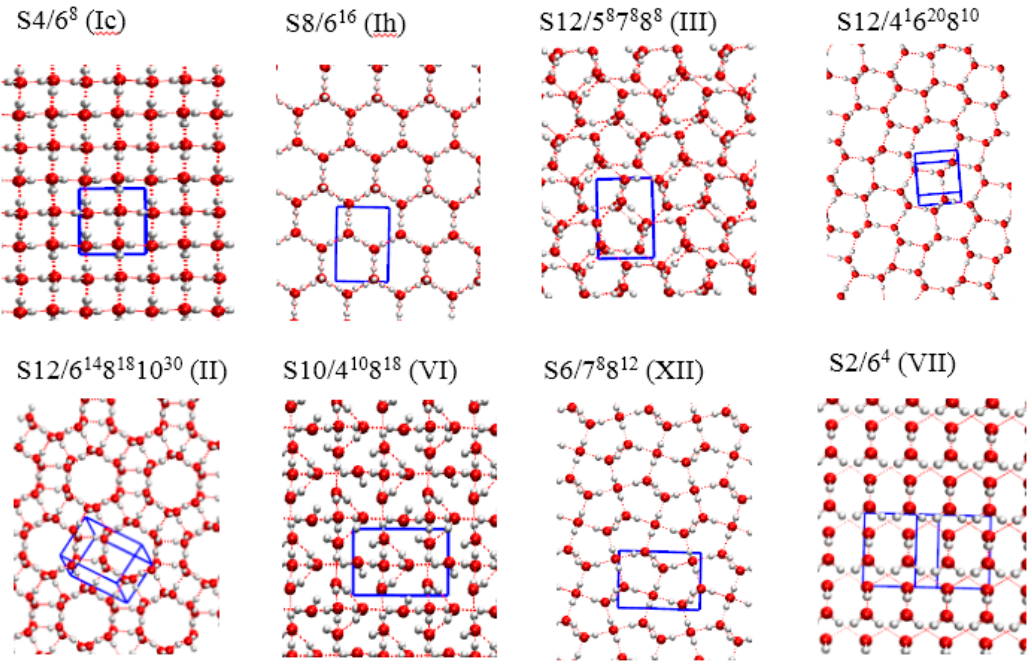
Figure 1. Crystal structures and unit cells for several selected structures.